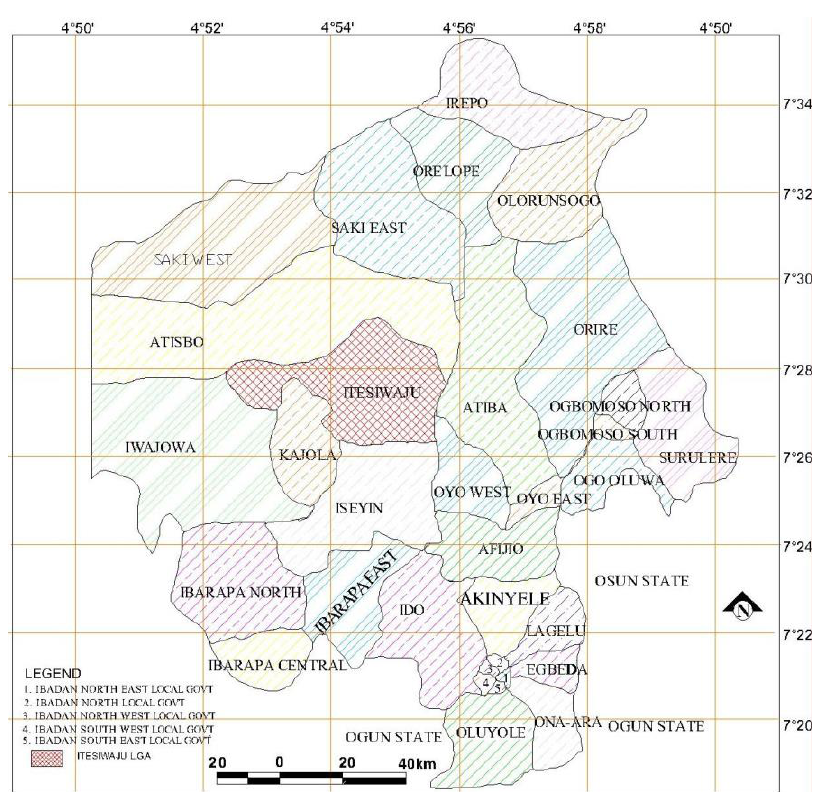
Fig. 2. Map of Oyo State showing Itesiwaju